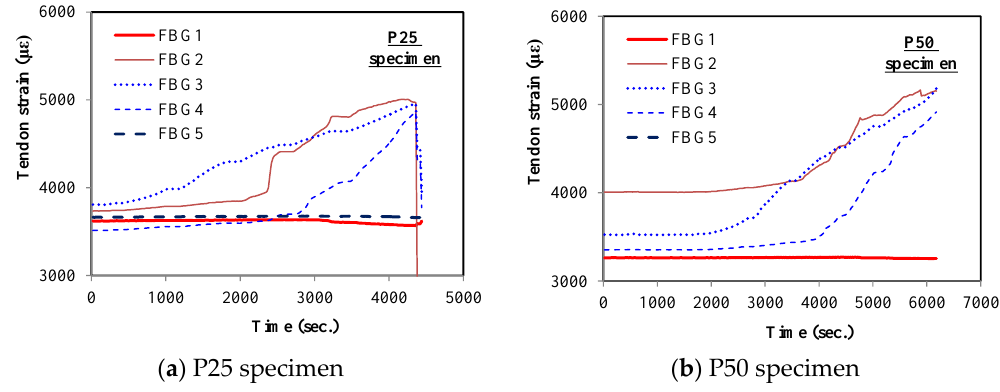
Figure 13. Tendon strain of specimens in relation to time.